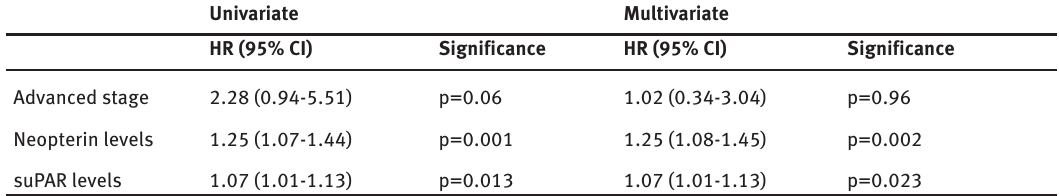
Table 3: Cox regression